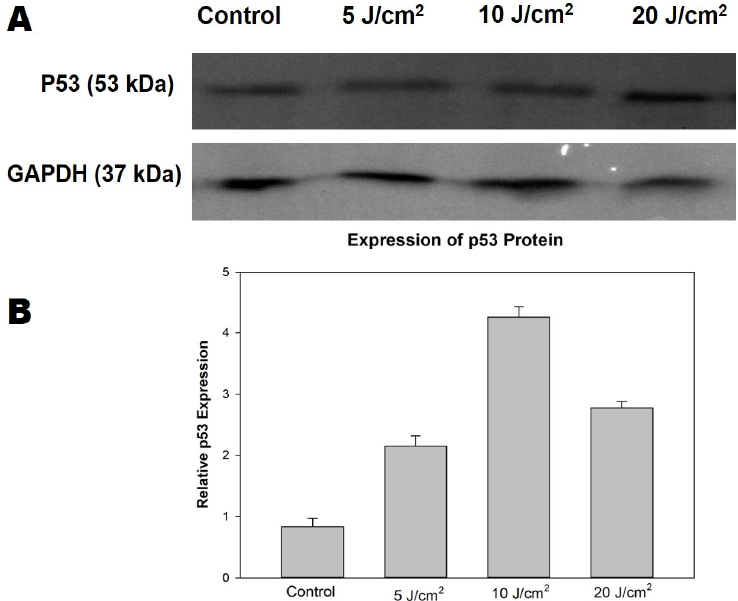
Figure 5. The ZnPcS4-PDT induced expression of p53 on MCF-7/DOX cells ( A ). Protein expression in bands on SDS-Polyacrylamide gel detected using ChemiDoc MP imaging system (Bio-Rad, USA). The protein bands were quantified using ImageJ software and represented in the histogram ( B ) based on the relative expression value of the grayscale bands corresponding to p53 compared to the housekeeping gene (GAPDH).